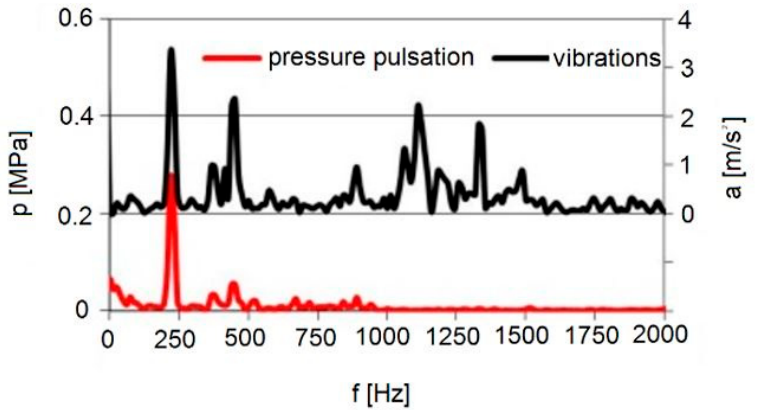
Figure 3. Amplitude-frequency spectrum of the pressure pulsations and mechanical vibrations of a hydraulic line.